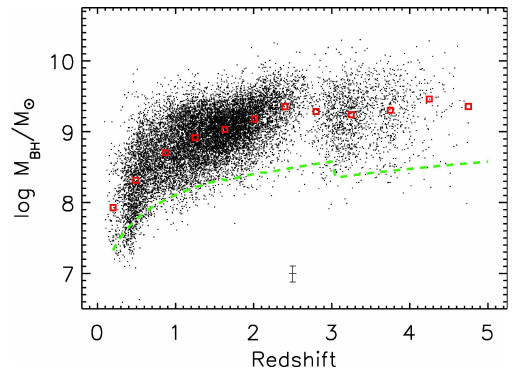
Figure 2: The SDSS plot of the CE masses M(z) of all the ( (cid:38) 10 4 ) sampled galaxies by the Sloan Digital Sky Survey. as functions of cosmicredshift z ( ≥ 0.2), [Vestergaard et al, 2008]. Small squares denote (verti- cal) averages at fixed redshift bin. The plot shows that M(z) decreases monotonicly, from 10 9 . 3 M (cid:12) at z = 4.5 down to (cid:46) 10 8 M (cid:12) at the smallest plotted redshift, z =